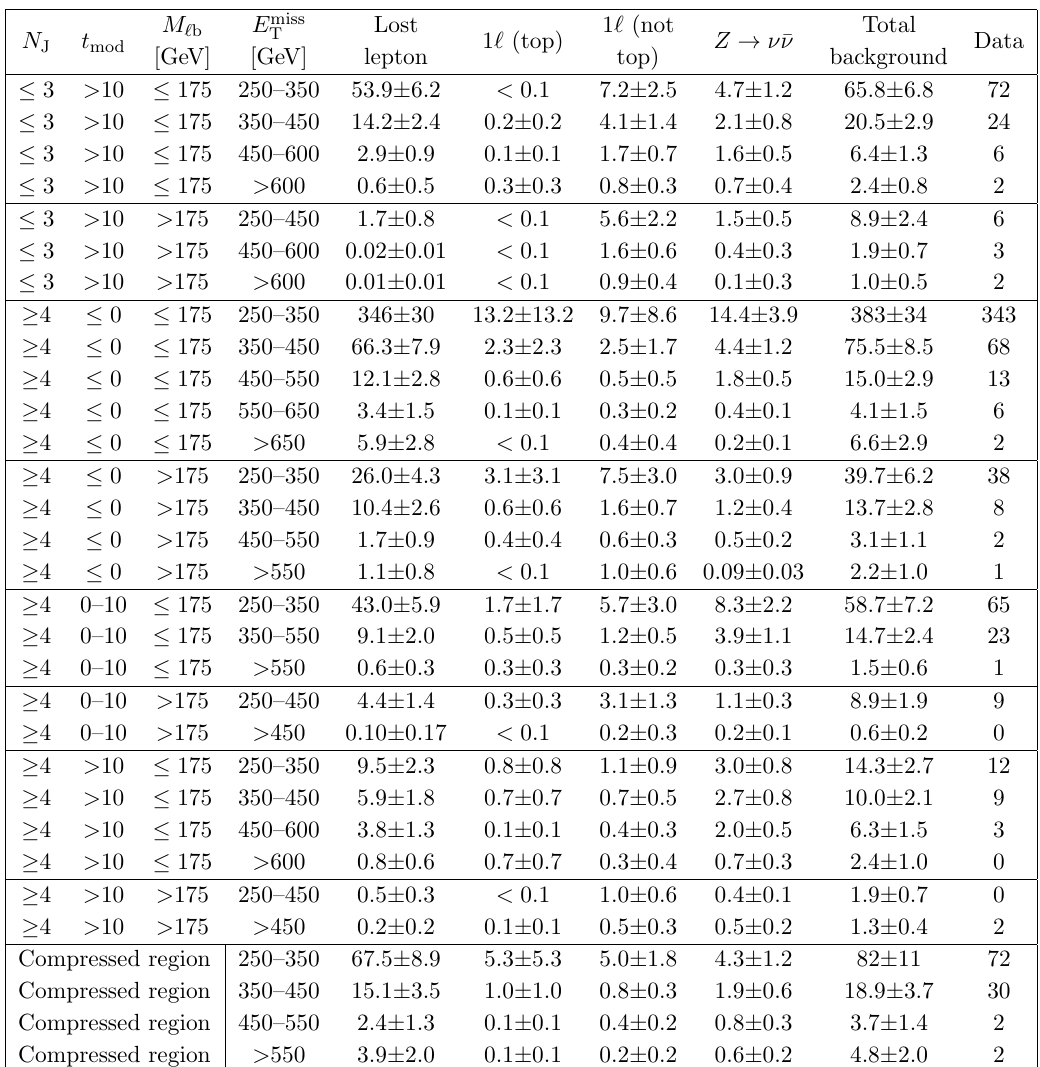
Table 5 . Result of the background estimates and data yields corresponding to 35.9 fb (cid:0) 1 , for the 31 signal regions of tables 2 and